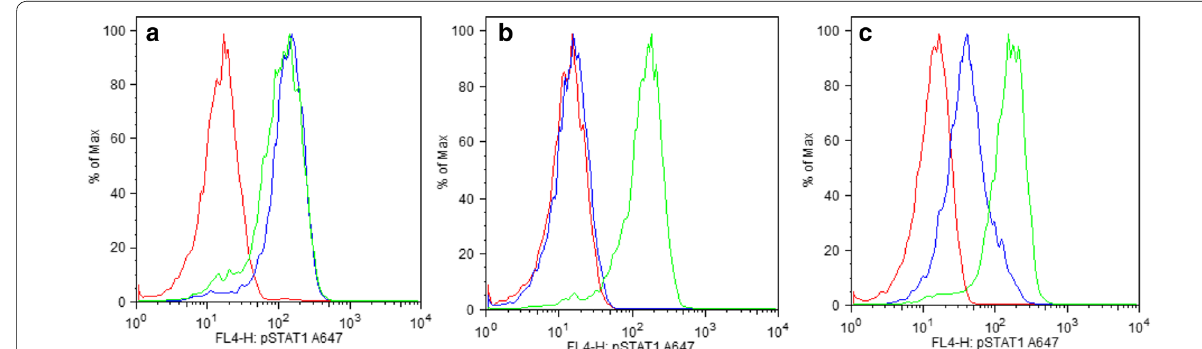
Fig. 2 One SS patient contains partially neutralizing activity against interferon-α autoantibodies. PBMC were stimulated with interferon-α and interferon-γ in the absence and presence of serum. Phospho-STAT-1 monoclonal antibody followed by an anti-mouse-FITC secondary antibody was used for immunostaining. Each graph contains a red, blue, and green, line which represent cells unstimulated or stimulated by interferon-α, or interferon-γ, respectively. a HV control serum did not interfere with cell signaling by interferon-α and interferon-γ leading activation and phosphorylation of STAT-1. b In a thymoma patient serum, the presence of only anti-interferon-α autoantibodies block interferon-α binding therefore preventing phosphorylation. c SS patient #56, containing an intermediate level of serum anti-interferon-α autoantibodies can block some, but not all, interferon-α signaling activity leading to a partial block of